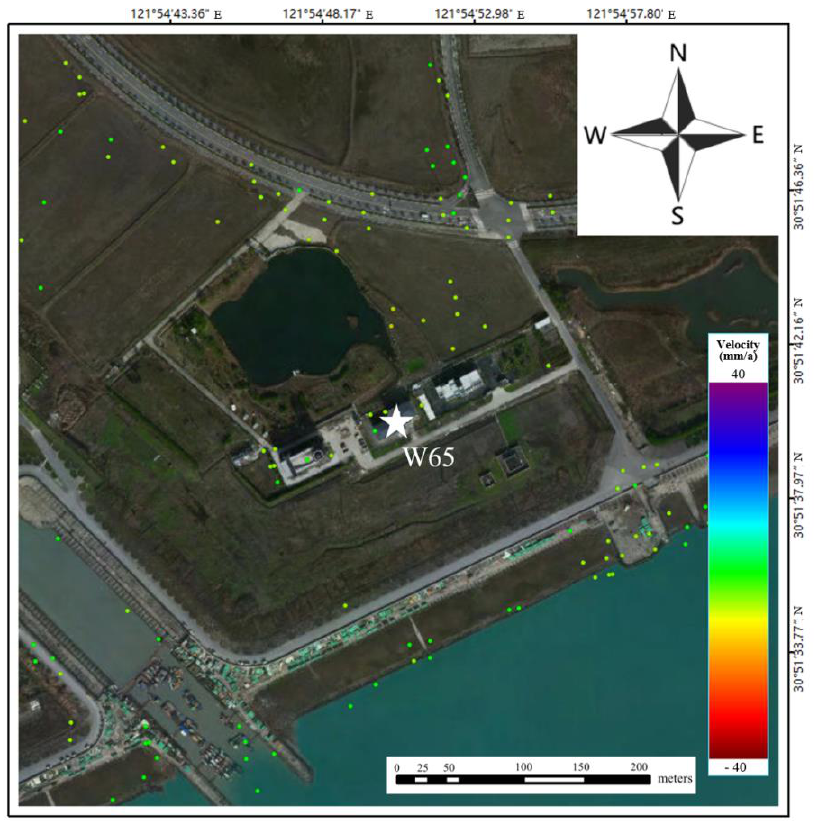
Figure 9. The distribution and deformation rate of PS points around groundwater well W65. Figures 11 and 12 show the relationships between the groundwater level monitoring value of the fourth confined aquifer and the surface deformation obtained by the InSAR technique. During the observation period, the groundwater level of W65-4 (the fourth confined aquifer of groundwater monitoring well W65) varied within 2 m and had notable seasonal fluctuations. It is well documented that the groundwater level starts to rise in winter and spring and starts to decrease in summer and autumn. The ground deformation value obtained by the PSInSAR method at the monitoring well W65 is around 2 mm within two years, and the average deformation rate is − 0.3 mm/year. The ground deformation trend is consistent with the variation of groundwater level data. The variation between InSAR results and groundwater level data had some relevance. It can be considered that it is stable relatively. On the other hand, during the observation period, the groundwater well level of W66-4 was quite steady before August 2017, and from August 2017 to May 2018 had undergone tremendous changes, but it still has the same deformation trend as the InSAR deformation results in the